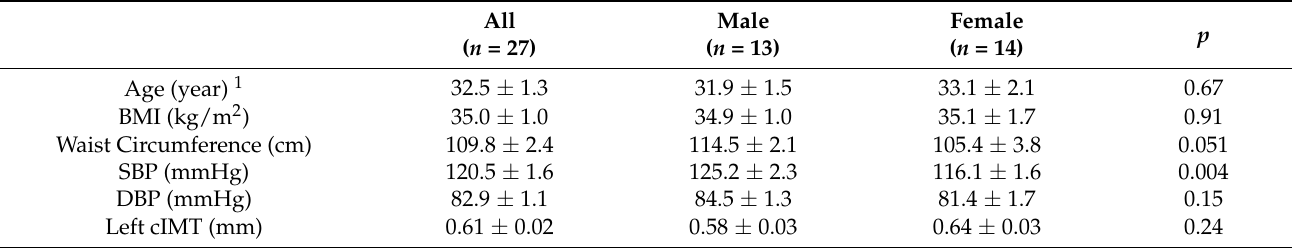
Table 2. Characteristics of MetS persons who completed a randomized controlled trial that examined 2-w consumption of a Dietary Guidelines for Americans -based diet containing a daily serving of a potato or